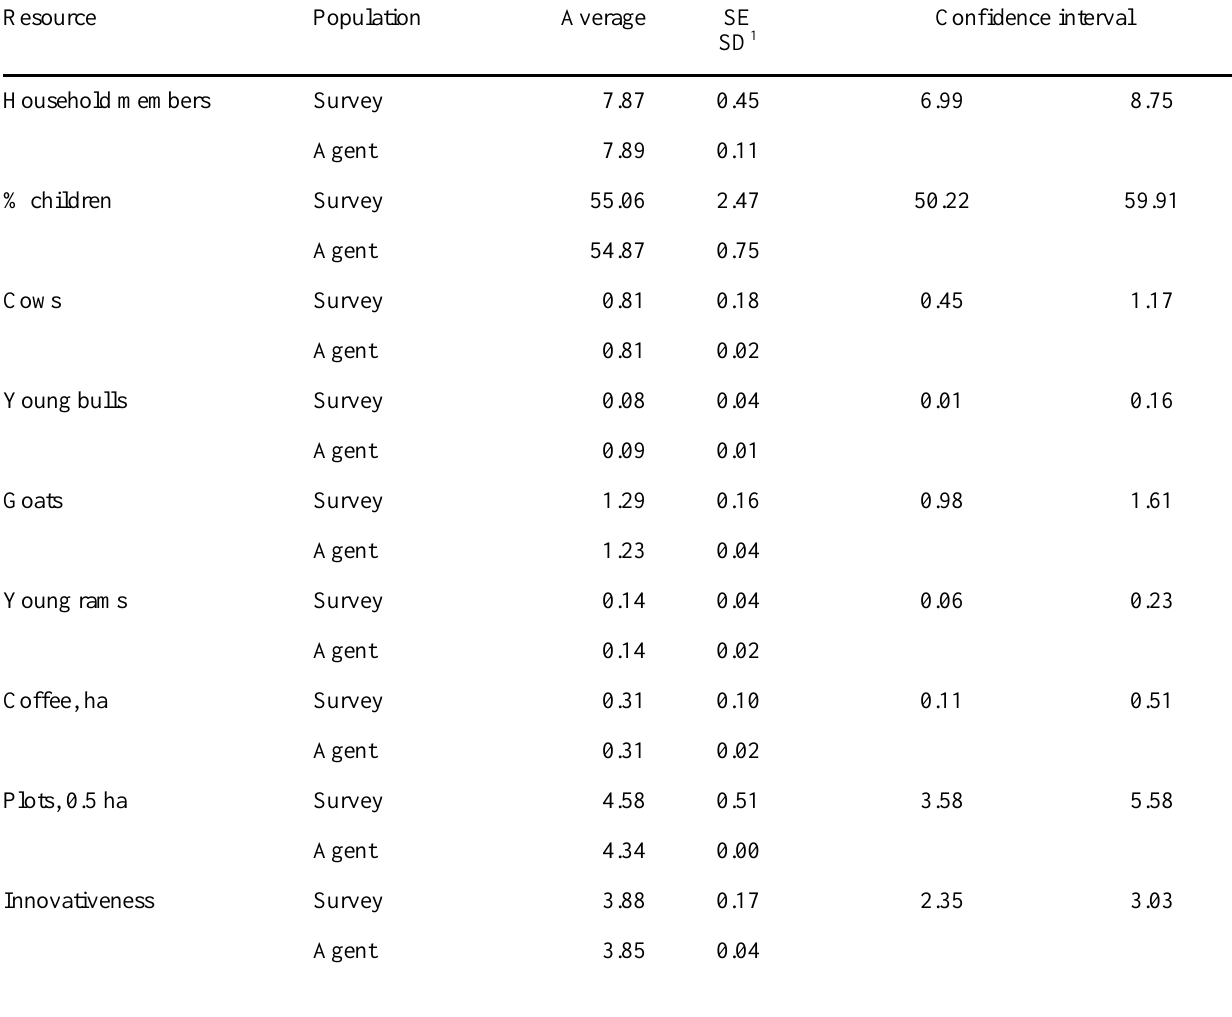
Table 1. Resource endowments of the survey population compared to meta-averages of the agent population. Agent population is an average over 100 different agent populations. SE is the standard error of the average referring to the average within the survey population and SD is the standard deviation of the average referring to the average across agent